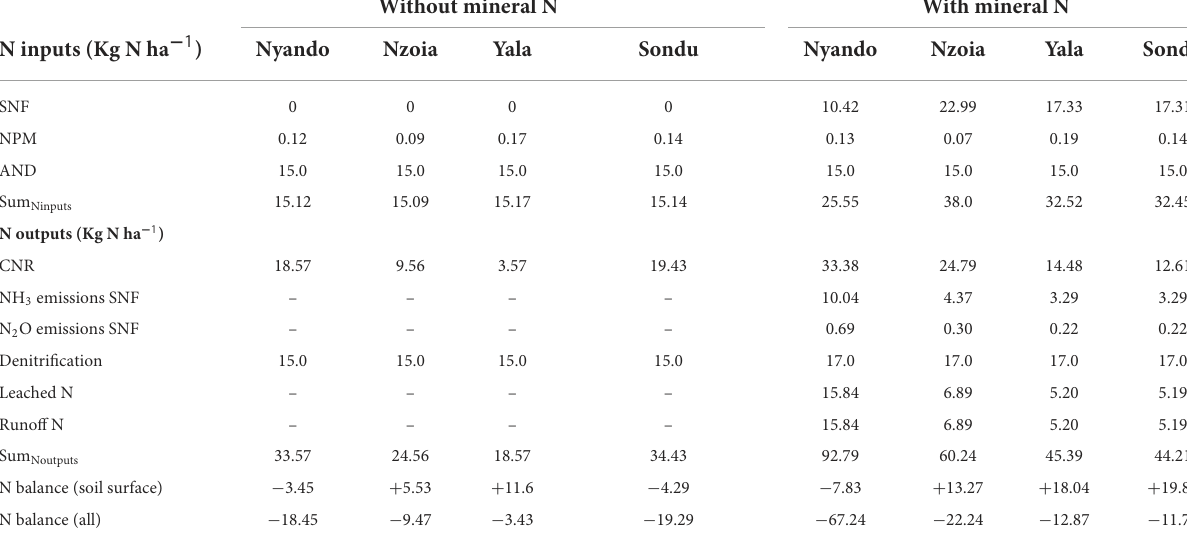
TABLE 1 Soil system N budget for maize with and without mineral N fertilizer applications in four Lake Victoria catchment. Without mineral N With mineral